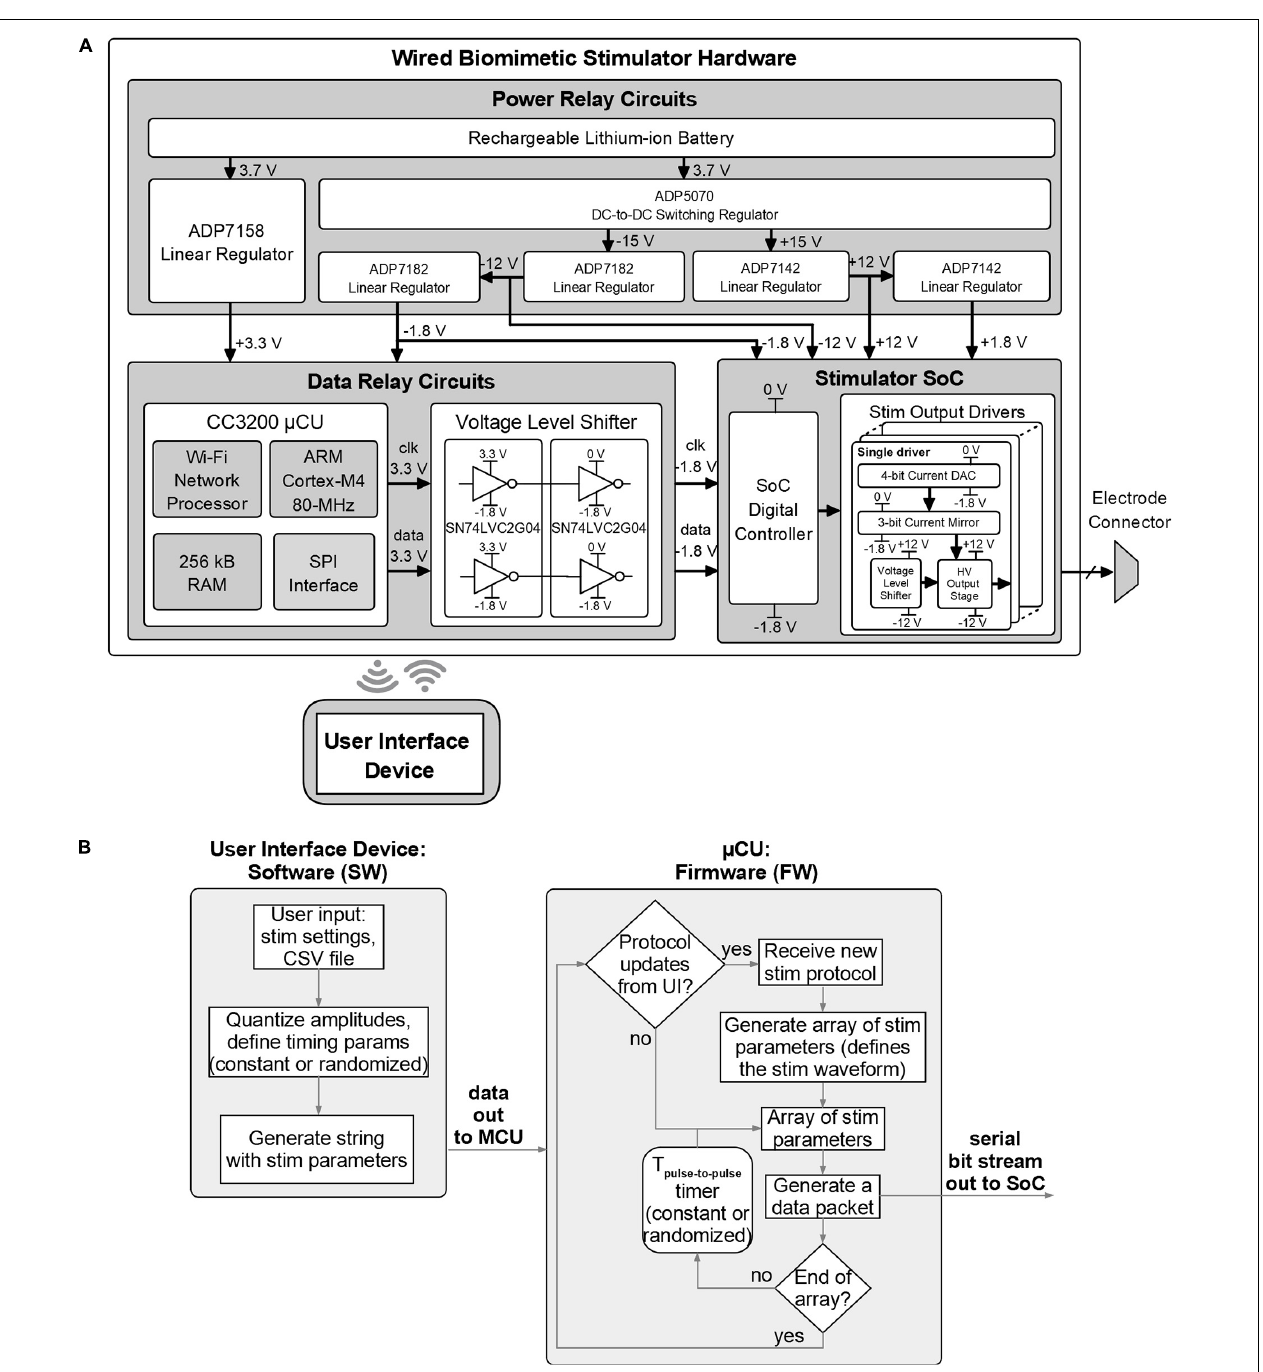
FIGURE 6 | Design details of the biomimetic stimulator prototype. (A) Block diagram and schematic of the hardware. Wired arrangement was chosen for initial rapid prototyping and in vivo verification. (B) Functional blocks of the software and firmware of the